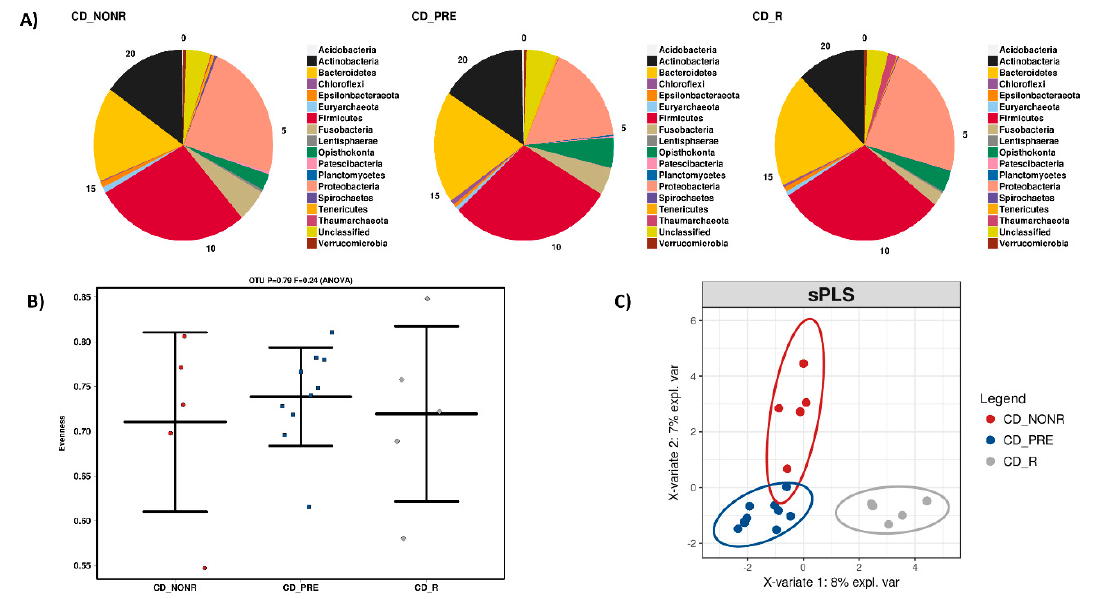
Figure 4. ( A ) Microbiota composition at phylum level among Crohn’s disease patients before treatment (CD_PRE) and after treatment in non-responders (CD_NONR) and responders (CD_R). ( B ) α -diversity (quantification of biodiversity) di ff erences of the 3 groups. ( C ) β -diversity (qualitative enterotype di ff erences) of the 3